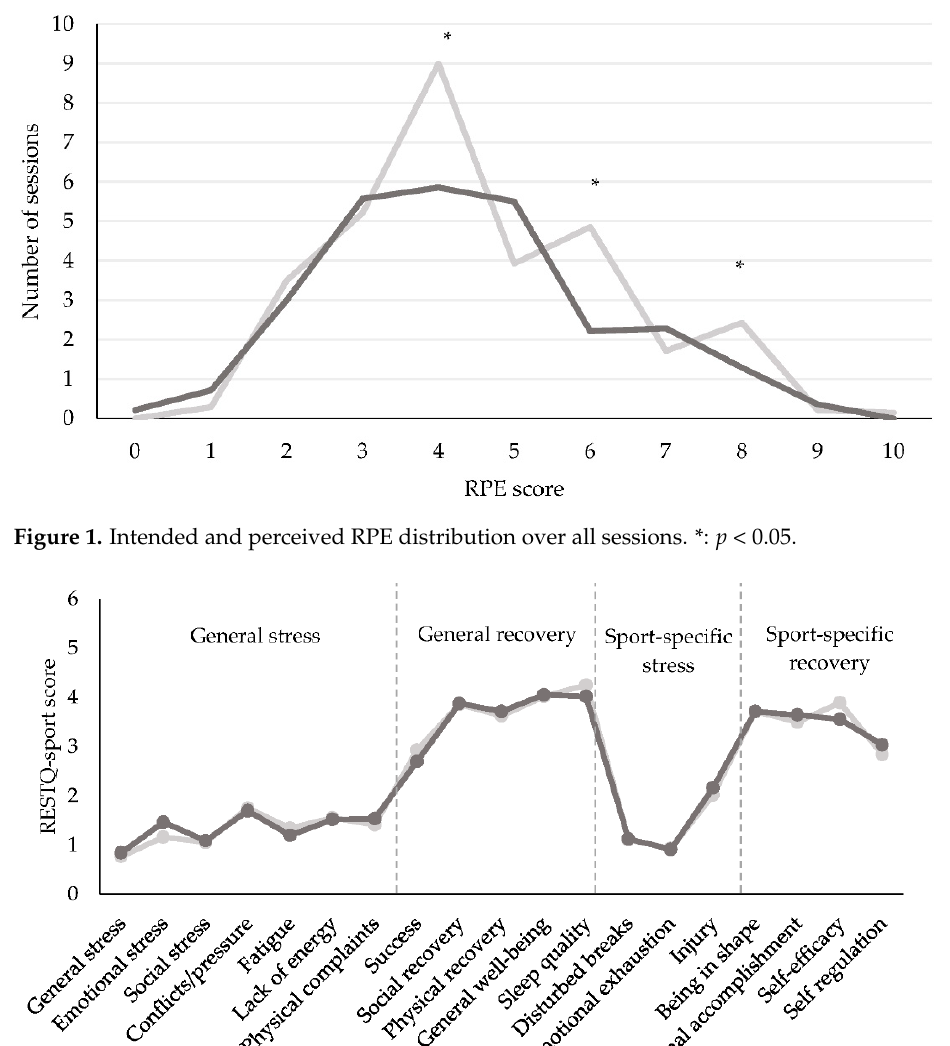
Figure 1. Intended and perceived RPE distribution over all sessions. *: p < 0.05.